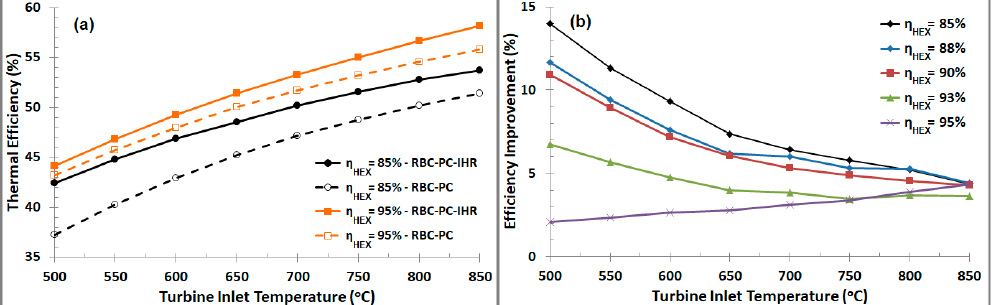
Figure 8. ( a ) Cycle thermal efficiencies versus turbine inlet pressure with heat exchanger effectiveness values of 85% and 95%. ( b ) Improvement in thermal efficiency from the RBC-PC-IHR compared to the RBC-PC in percentage points at different values of heat exchanger effectiveness between 85% and